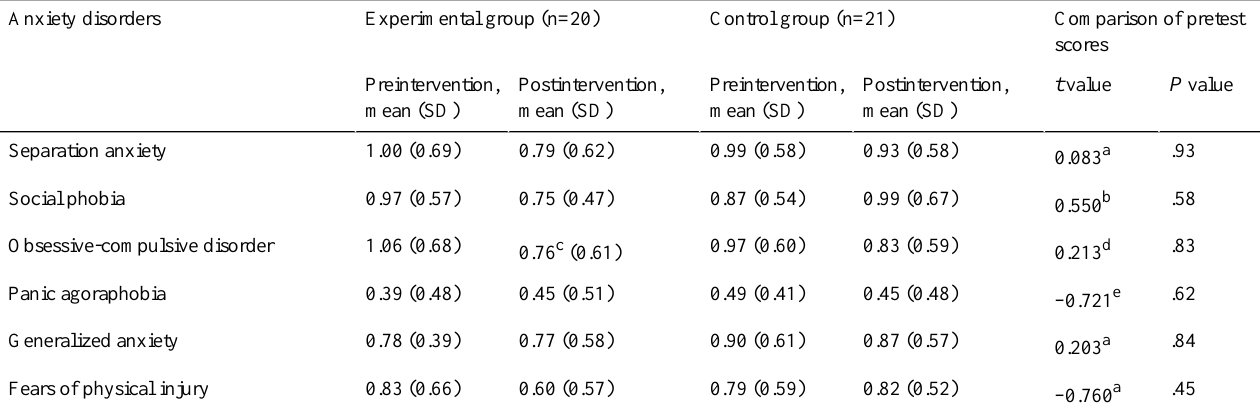
Table 4. Anxiety disorders before and after the intervention for the experimental and control